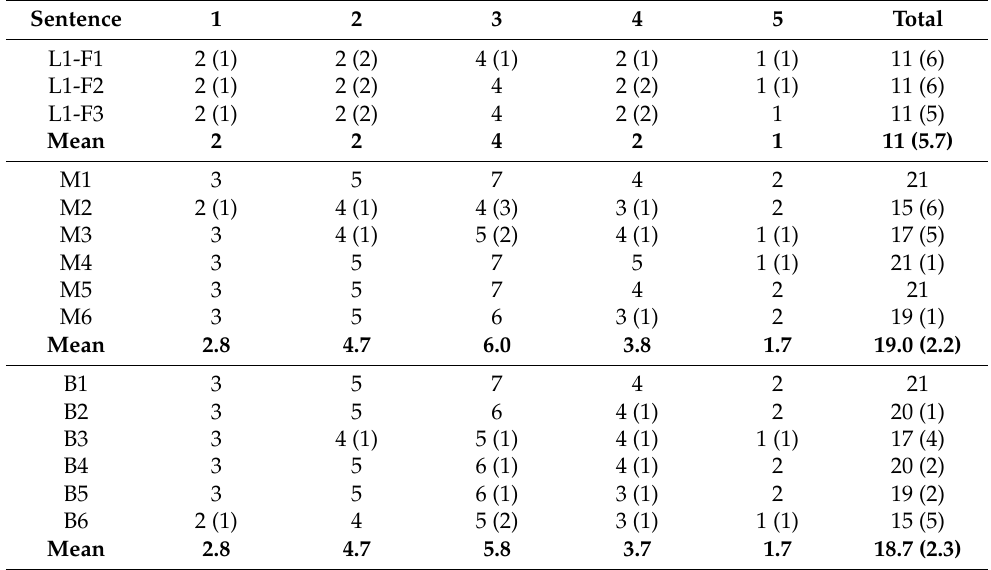
Table 5. Number of APs realized in the five target sentences. Uppermost panel: French natives (group L1-F); middle panel: monolingual learners (group M); lower panel: bilingual learners (group B). The numbers in brackets indicate the number of APs produced with an optional initial rise